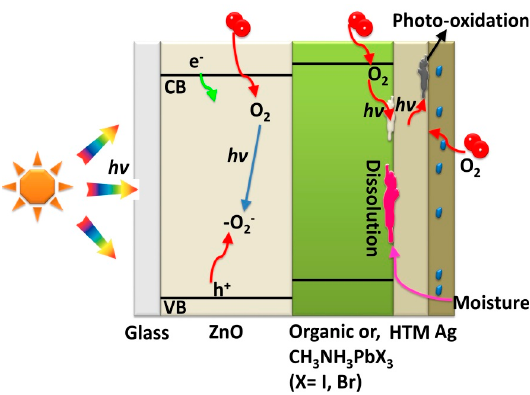
Figure 1. Schematic diagram of an organic/Perovskite solar cell (PSC) solar cell structure. The electron-hole pair recombination, moisture dissolution of perovskite material and photo-oxidation processes at the interface between hole transport materials (HTM) and metal electrode are shown. Adapted with permission from [9]. Copyright 2018 Royal Society of Chemistry.